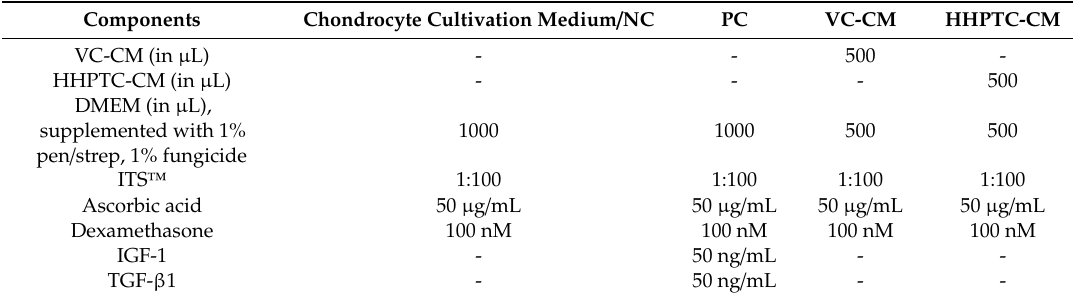
Table 1. Composition of tested